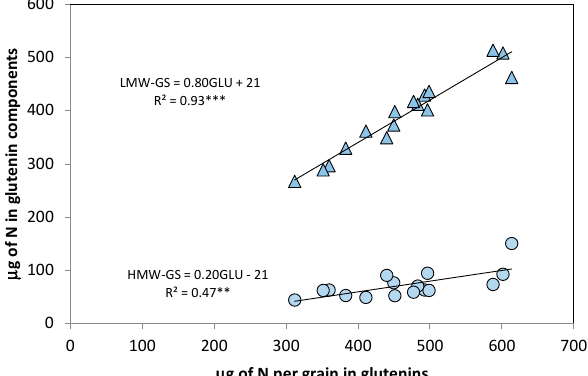
Figure 4. Relationships between the variation in the µg of total glutenins per grain and the amount of the two glutenin components: LMW-GS (triangles) and HMW-GS (circles). Points are cultivar means across years and N treatments. *** p < 0.001, ** p < 0.01.